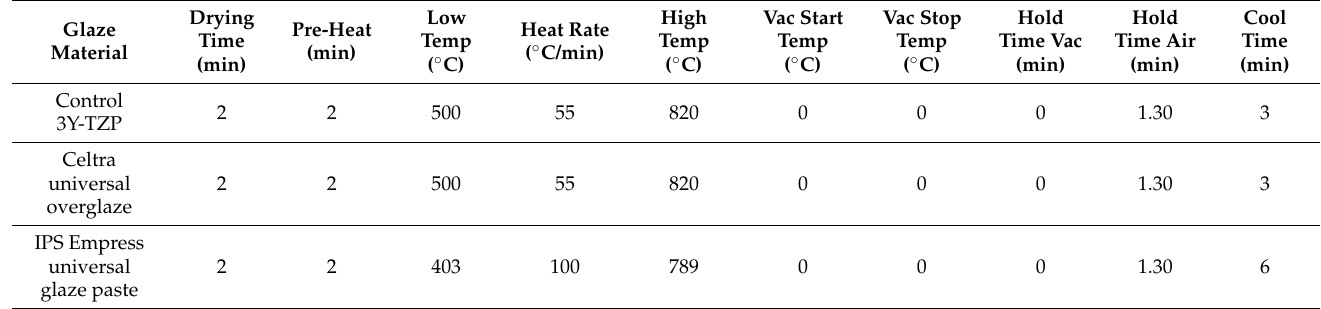
Table 3. Glaze firing protocol used for two glaze materials and the control